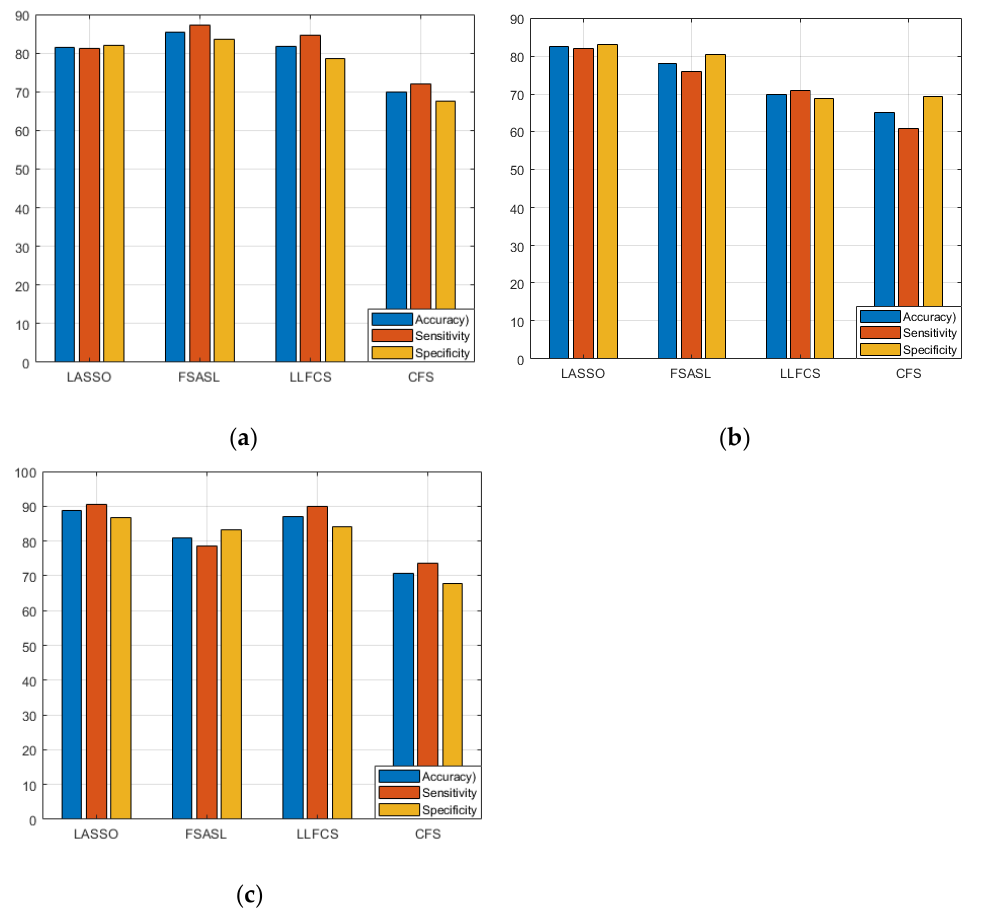
Figure 6. Classification performance using ML-RELM classifier on whole brain network using dif-